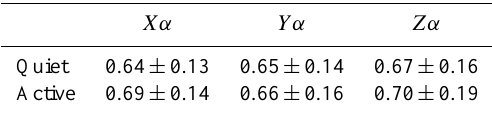
Table 4. Scaling exponents for the quiet and active events computed for all latitudes.